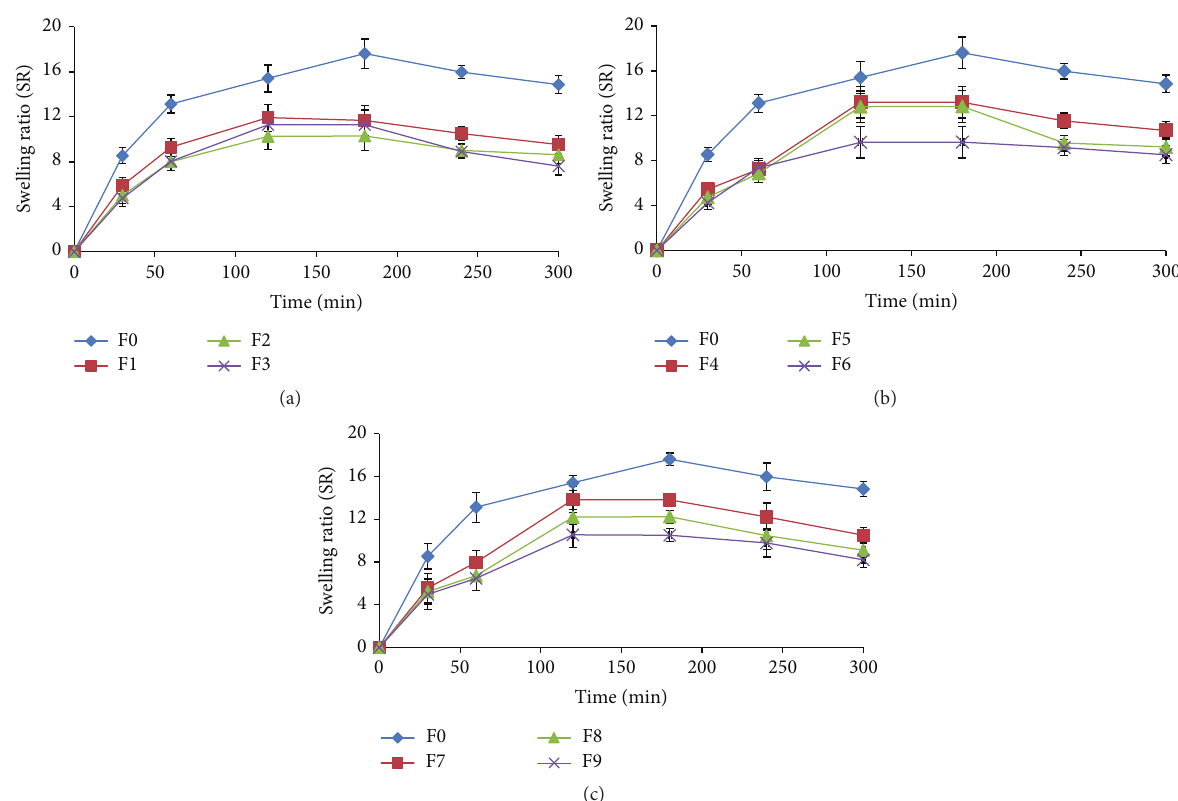
Figure 2: Swelling ratio (SR) of microspheres placebo (F0) and formulations F1–F3 (a), F4–F6 (b), and F7–F9 (c).